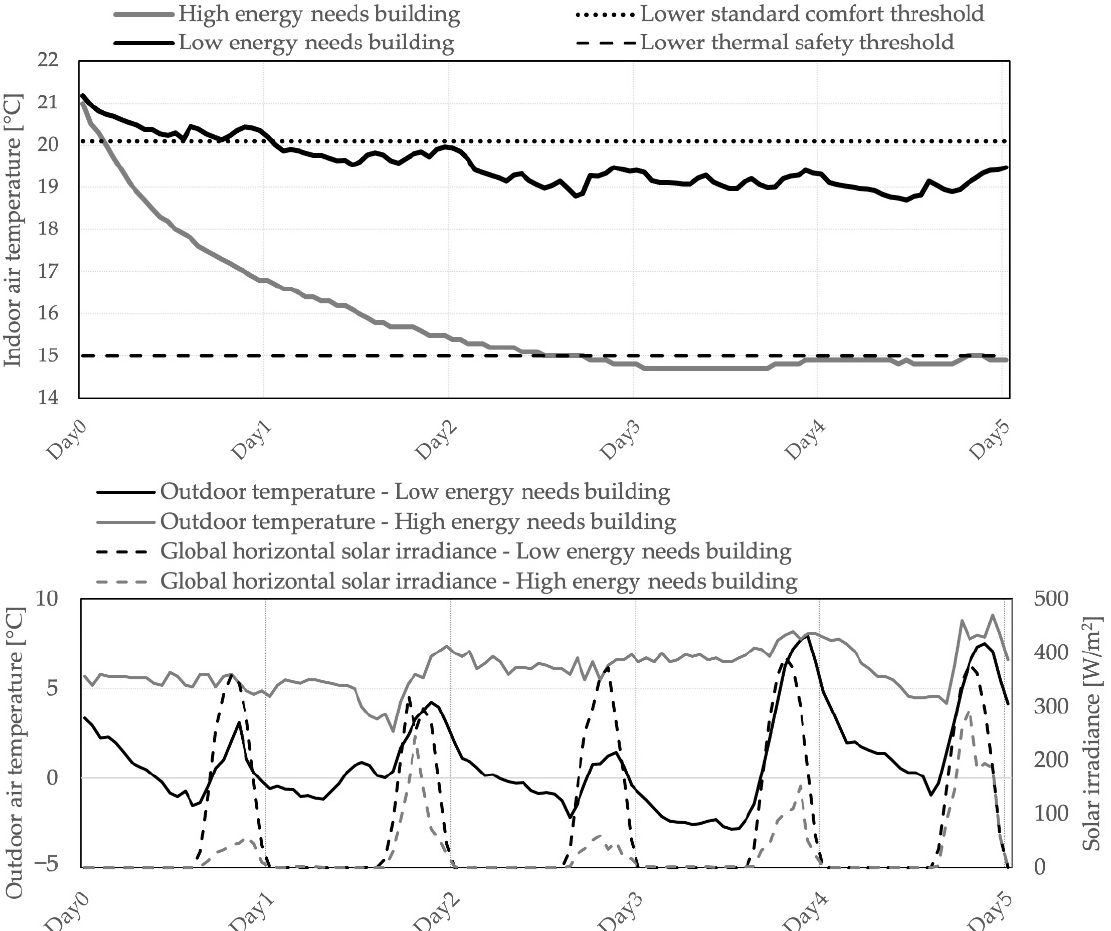
Figure 13. Thermal behavior after a power outage in a low-energy-needs building (northeast oriented flat (F1-03-NE) of the case study discussed in this paper) and in a high-energy-needs building (east oriented flat of a multiapartment building located in Milan).